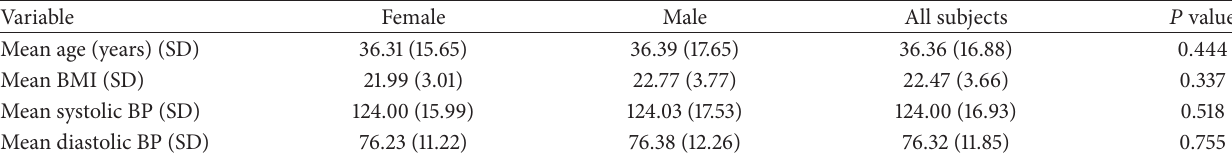
Table 1: Characteristics of the subjects.